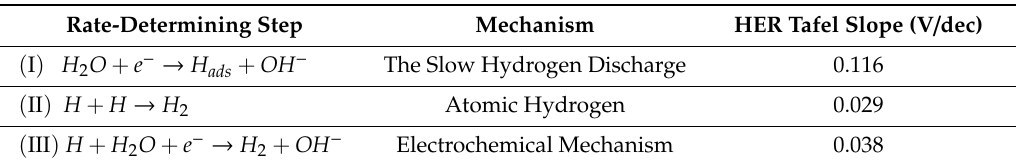
Table 4. Rate-determining steps in hydrogen evolution reaction (HER) and corresponding Tafel slopes